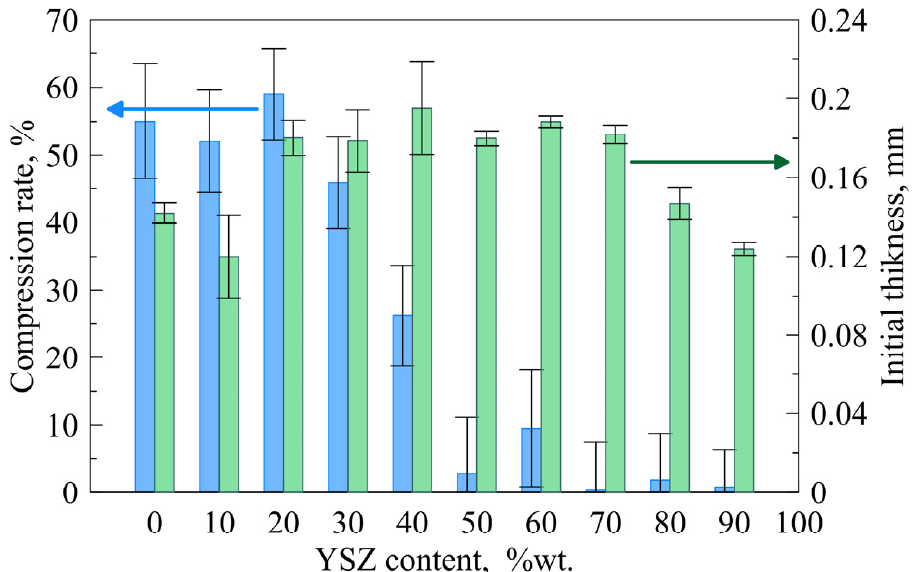
Figure 6. Compression rate and initial thickness of the sample seals after the heating procedure vs. YSZ content.